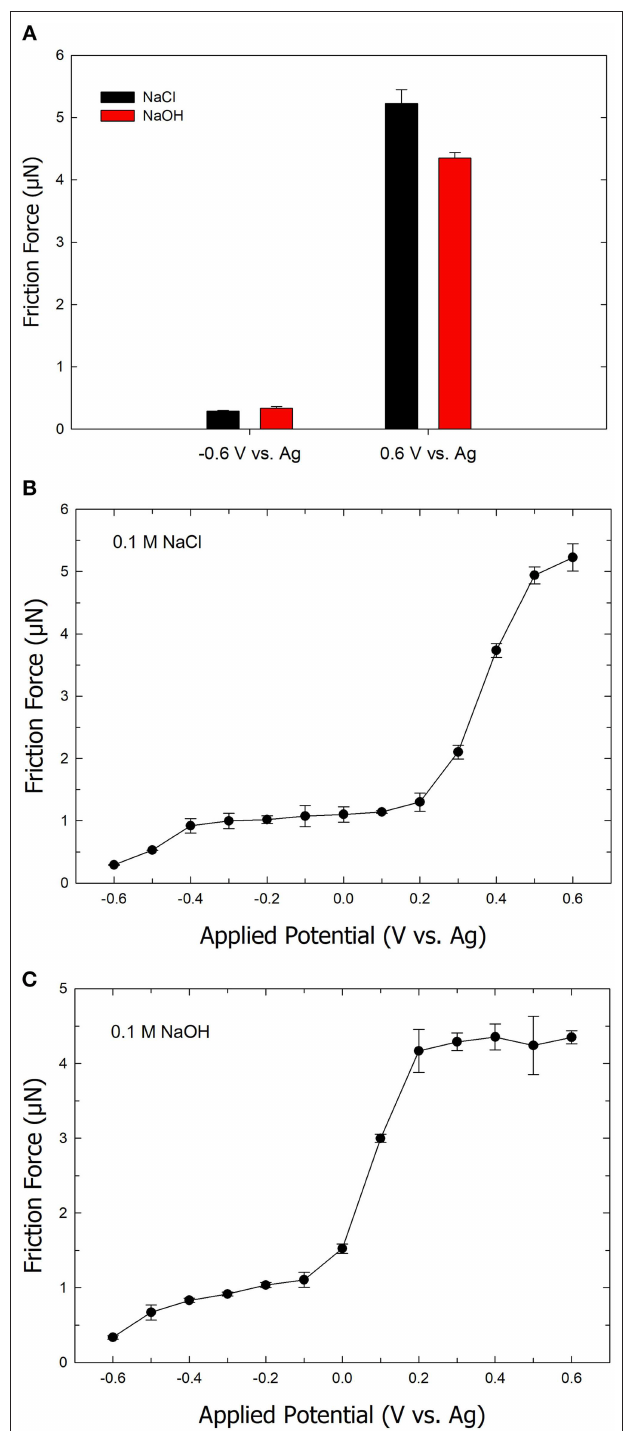
FIGURE 4 | (A) Bar chart of the friction force on ultra-smooth gold surface in an aqueous 0.1M NaCl solution (black) and an aqueous 0.1M NaOH solution (red). Plot of the friction force as a function of the applied potential in the range of – 0.6 to + 0.6V in (B) aqueous NaCl solution and (C) aqueous NaOH solution. Error bars indicate standard deviations from five repeats. The normal load is 2.5 µ